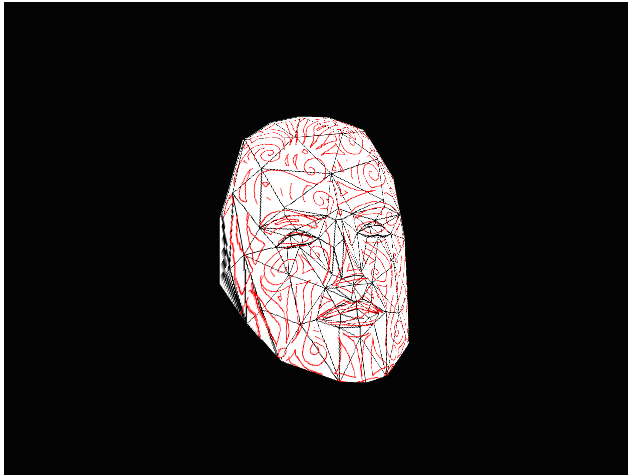
Fig. 9. An example of a texture-mapped mesh with overlaid wireframe.